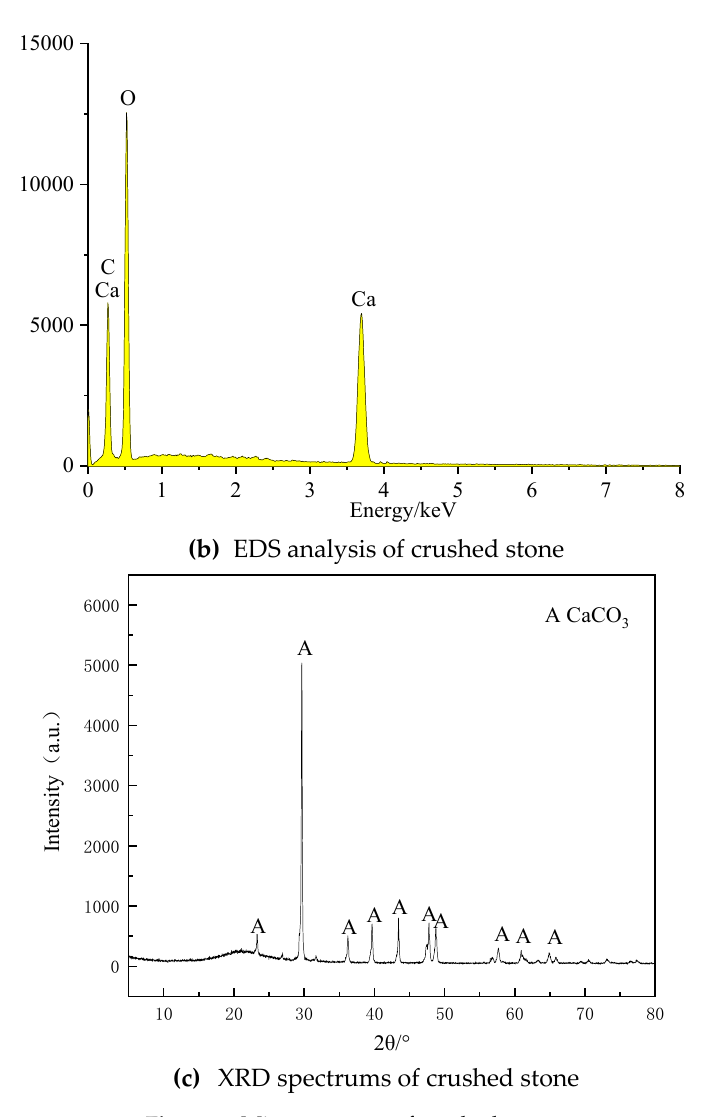
Figure 6. Microstructure of crushed stone. Table 4. Chemical elements of crushed stone (atomic fraction)/wt.%.